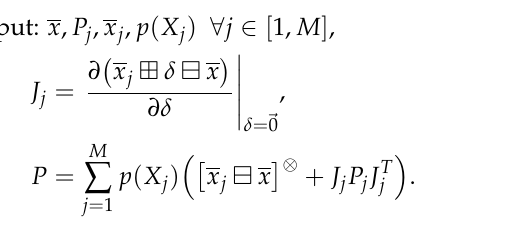
Table 1. Original IMM [8] vs. (cid:1) -IMM. Dashed boxes belong to the standard IMM only and full boxes to the (cid:1) -IMM. z k may be a (cid:1) -manifold